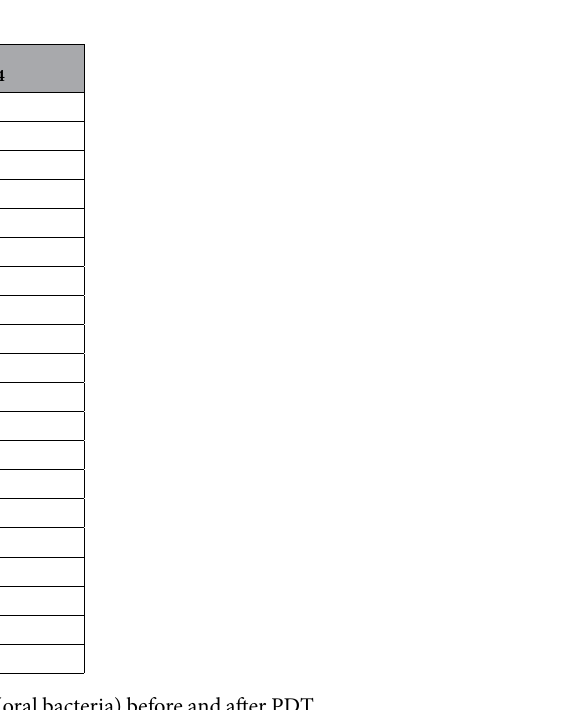
Table 3. Comparison of the microbial load (oral bacteria) before and after